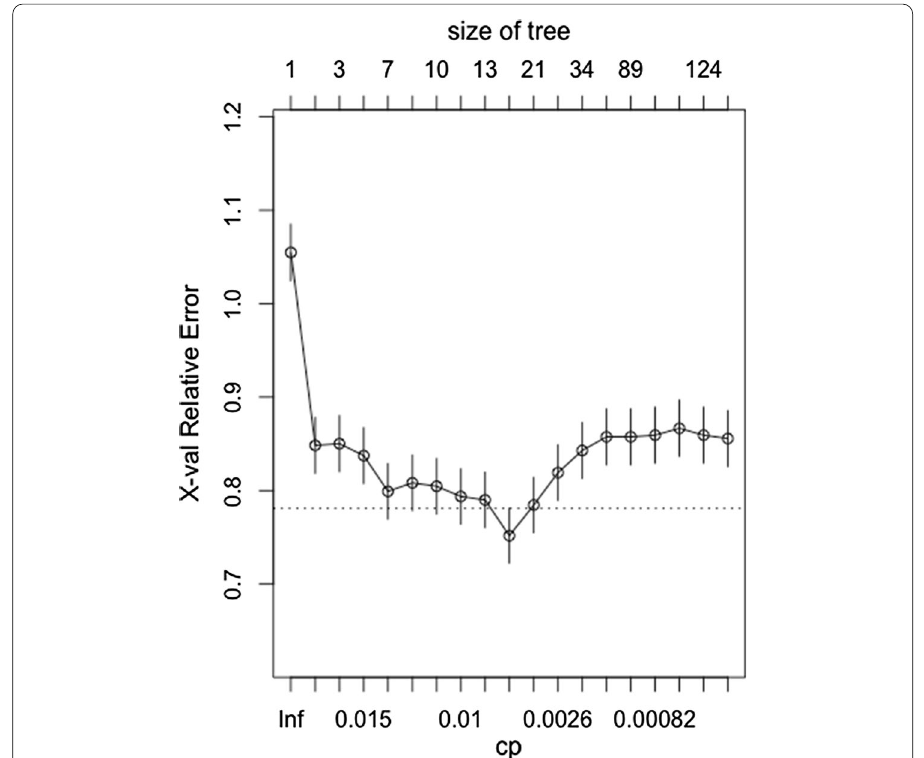
Fig. 9 Complexity Parameter for Topics Prediction. The optimum number of branches can be determined by the optimal CP value relative to the size of the tree and its relative